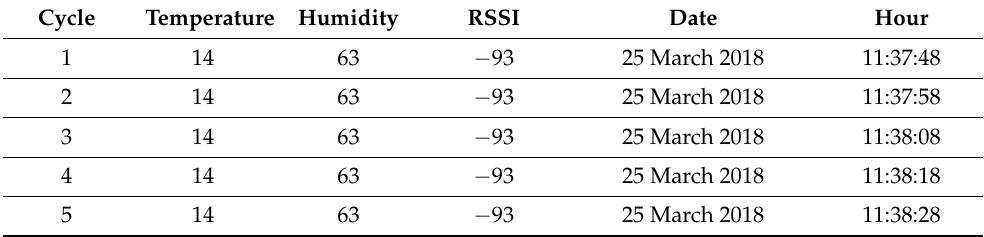
Table 1 . Steps to carry out a radio attenuation study based on RSSI inside a greenhouse .